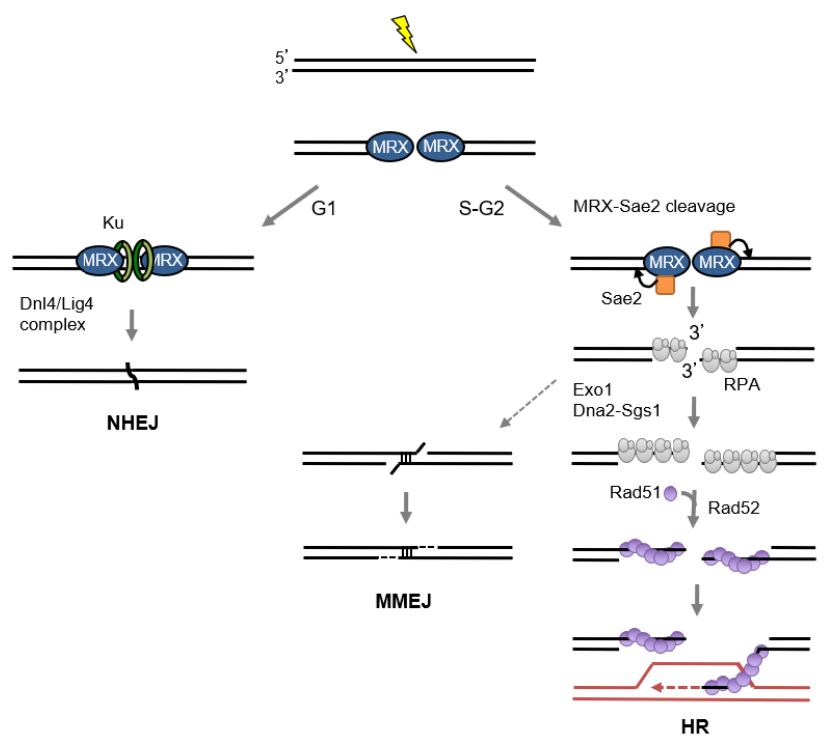
Figure 2. Overview of the DSB repair mechanisms. DSBs are repair by one of two major pathways: non-homologous end joining (NHEJ) or homologous recombination (HR). Classical NHEJ (C-NHEJ) directly re-ligates the two ends together while HR utilizes homologous template and is active in the S and G2 phases of the cell cycle when a sister chromatid is available. RPA initially binds to the 3 ′ ssDNA overhangs produced by end resection and is then replaced by Rad51 in a reaction requiring the Rad52 or BRCA2 mediator protein. The Rad51-ssDNA complex promotes the homology search and strand invasion, pairing the invading 3 ′ end with one strand of the donor duplex to template DNA synthesis. Resected intermediates can also be channeled to the MH-mediated end joining (MMEJ) pathway.